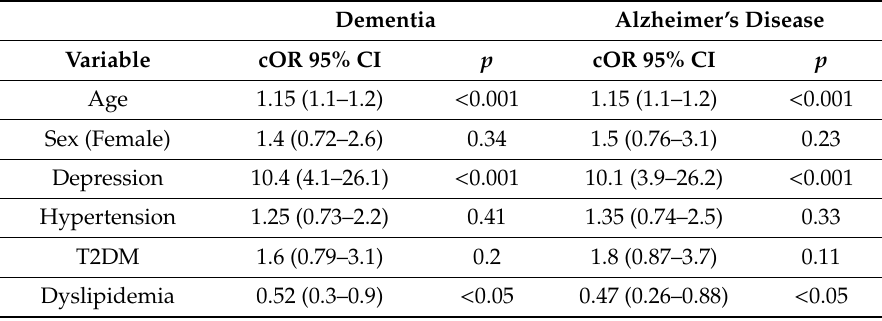
Table 2. Crude logistic regression (unadjusted) for dementia and AD.